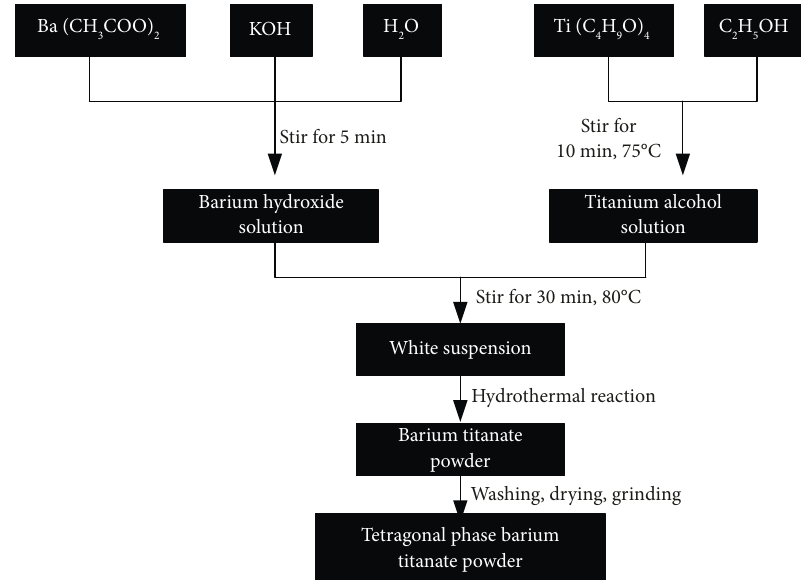
Figure 2: Preparation process of tetragonal phase barium titanate.